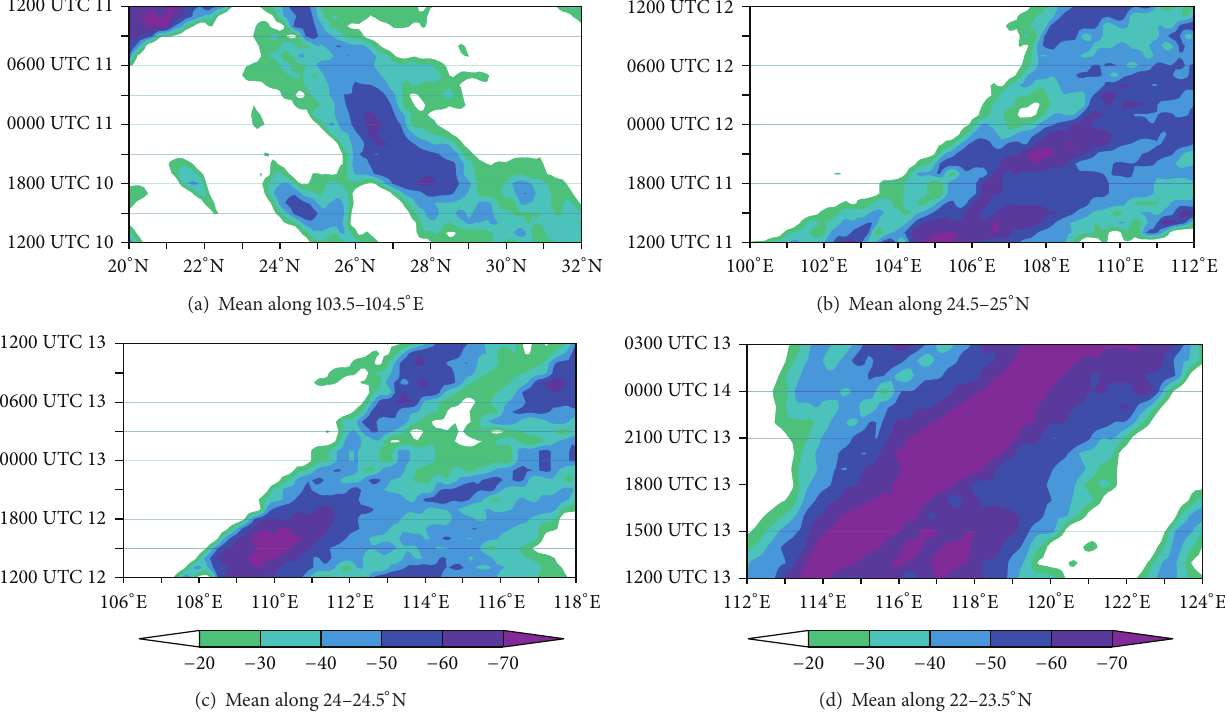
Figure 11: As in Figure 10, but at different date with (a), (c), (e), (g), and (i) for the